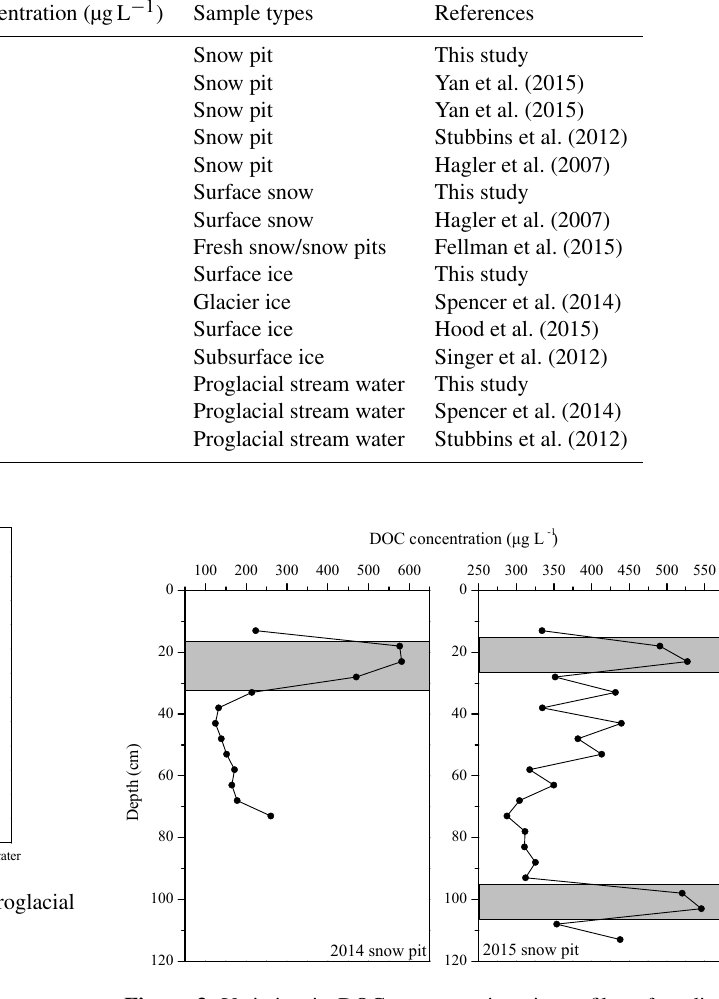
Figure 3. Variation in DOC concentrations in profiles of studied snow pits. The gray rectangles are dirty